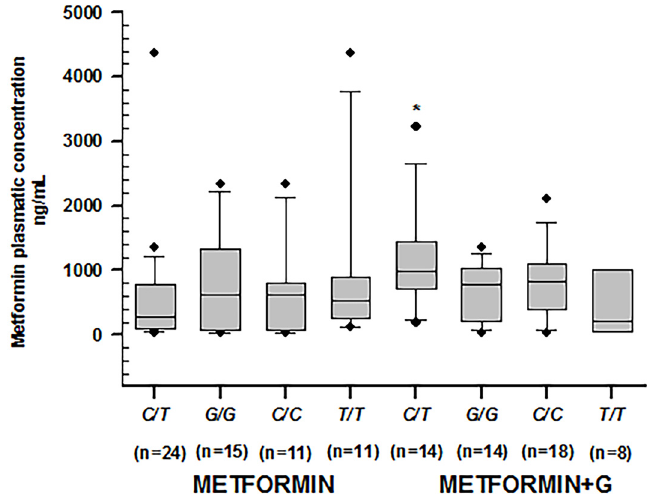
Figure 5. Metformin plasmatic concentration boxplots (ng/mL), including medians, interquartile ranges, and outliers (filled circles). From left to right: C/T of rs1128503; G/G of rs2032582; C/C of rs1045642; T/T of rs1045642, treated with metformin. The following boxplots correspond to the same genotypes under combined therapy. Only C/T of rs1128503 reported significant differences in both groups (* p = 0.002).